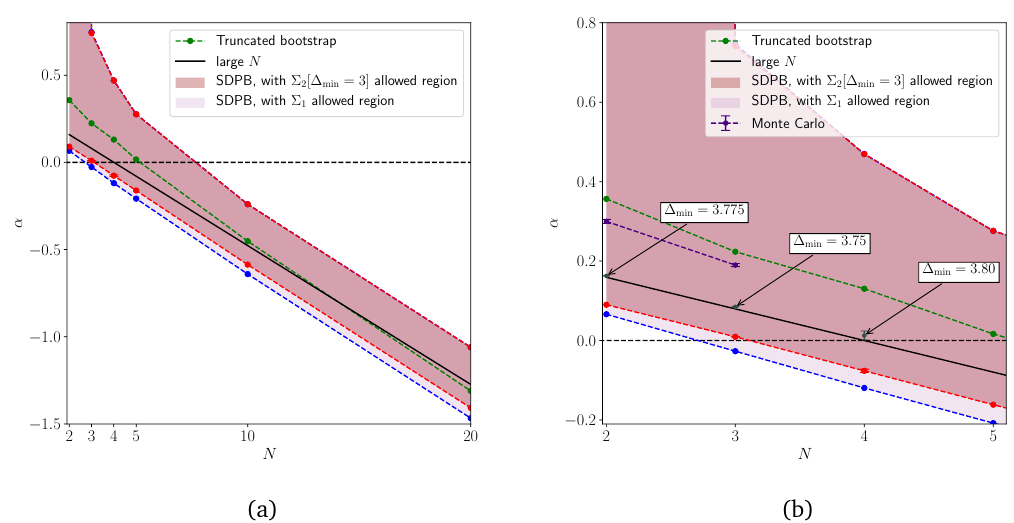
Figure 8: Various α ( N ) estimates compared. The convention for the shaded regions is the same as in figure 7. On the right, 8b is a zoomed version with more details around low values of N . It also highlights our extra runs with different ∆ for N = { 2,3,4 } as discussed in the text (shown in